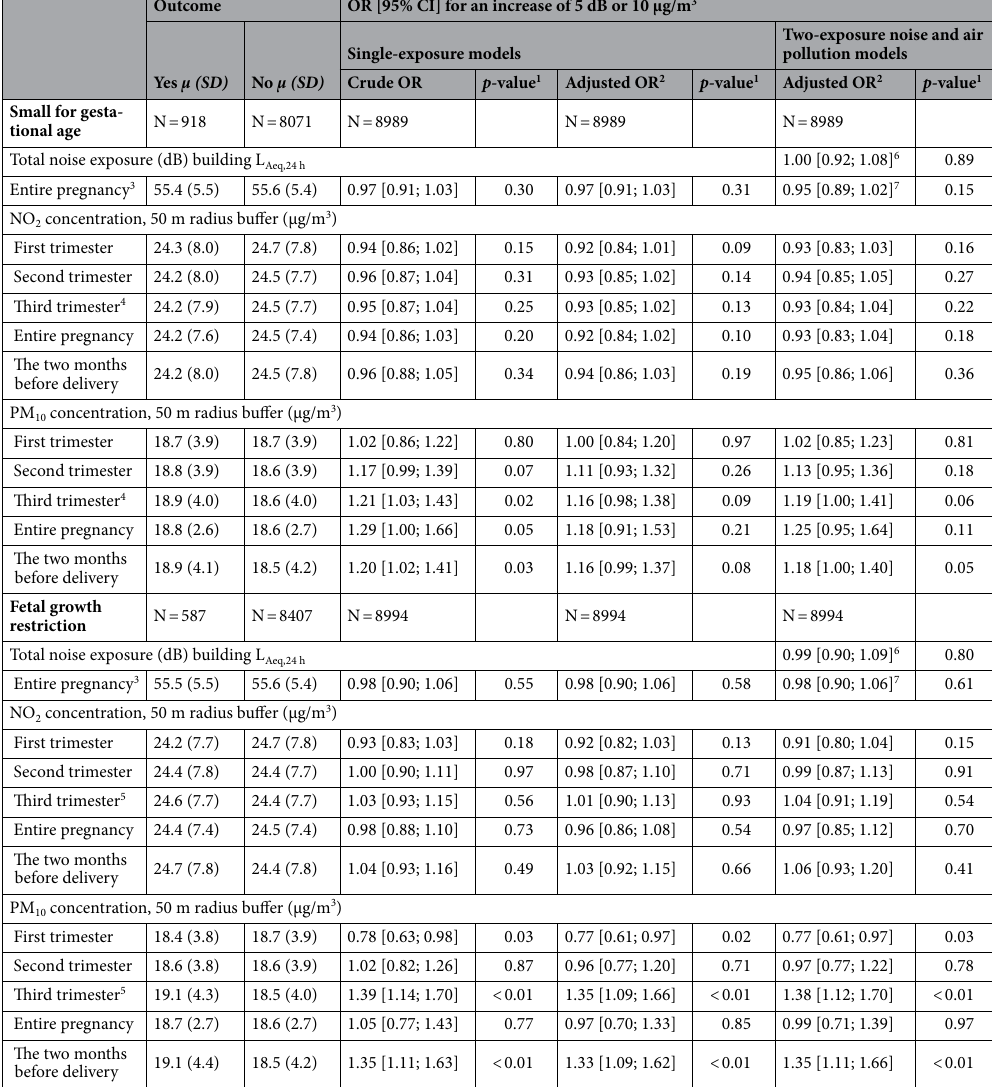
OR: Odds ratio; CI: confidence interval. 1 Wald Chi-square test. 2 Adjusted for term, maternal age above 35 years at delivery, low neighborhood socioeconomic level, maternal smoking during pregnancy, malnutrition and obesity, nulliparity, gestational hypertension, diabetes, assisted reproductive techniques, vaginal bleeding in the second and third trimesters, infection, major infant congenital abnormalities. 3 For NO 2 and PM 10 indices in adjusted analyses (the results were similar with the other period indices). 4 Missing data for delivery before 29 weeks of gestational age (n = 106). 5 Missing data for delivery before 29 weeks of gestational age (n = 107). 6 Noise and NO 2 . 7 Noise and PM 10